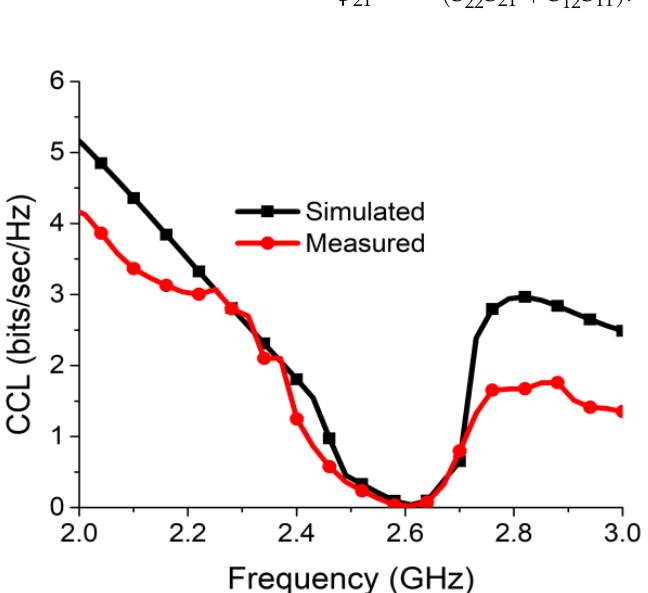
Figure 21. Channel capacity loss (CCL) of proposed antenna two-port MIMO antenna.